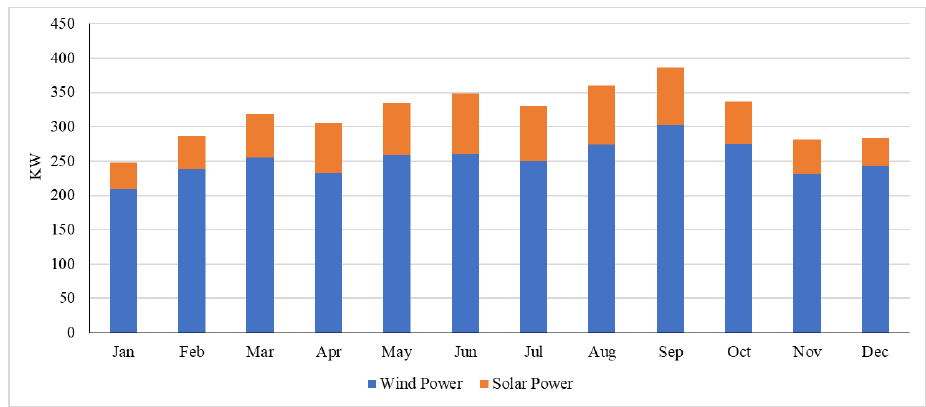
Figure 5. Simulated produced wind and PV power per month with the suggested hybrid system. Table 3. Operation characteristics of the suggested hybrid